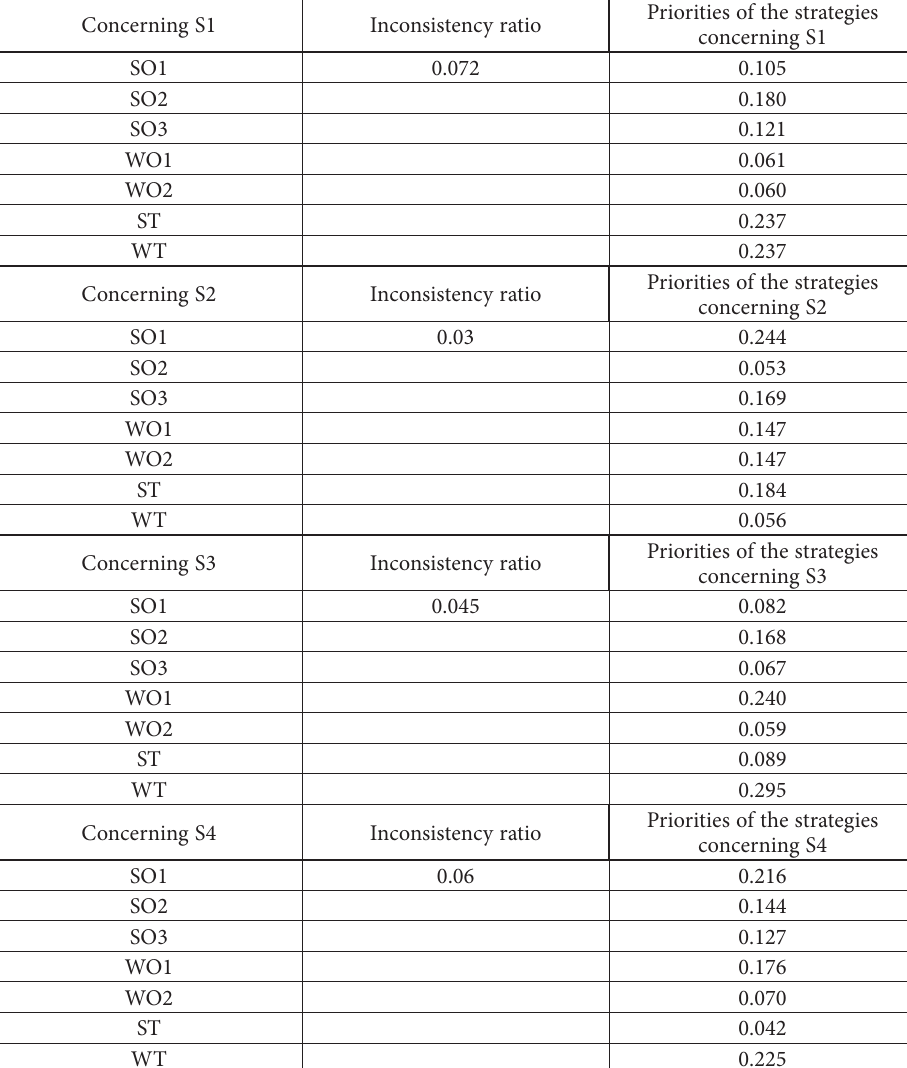
Table 9. Pair-wise comparisons of the strategies in relation to the